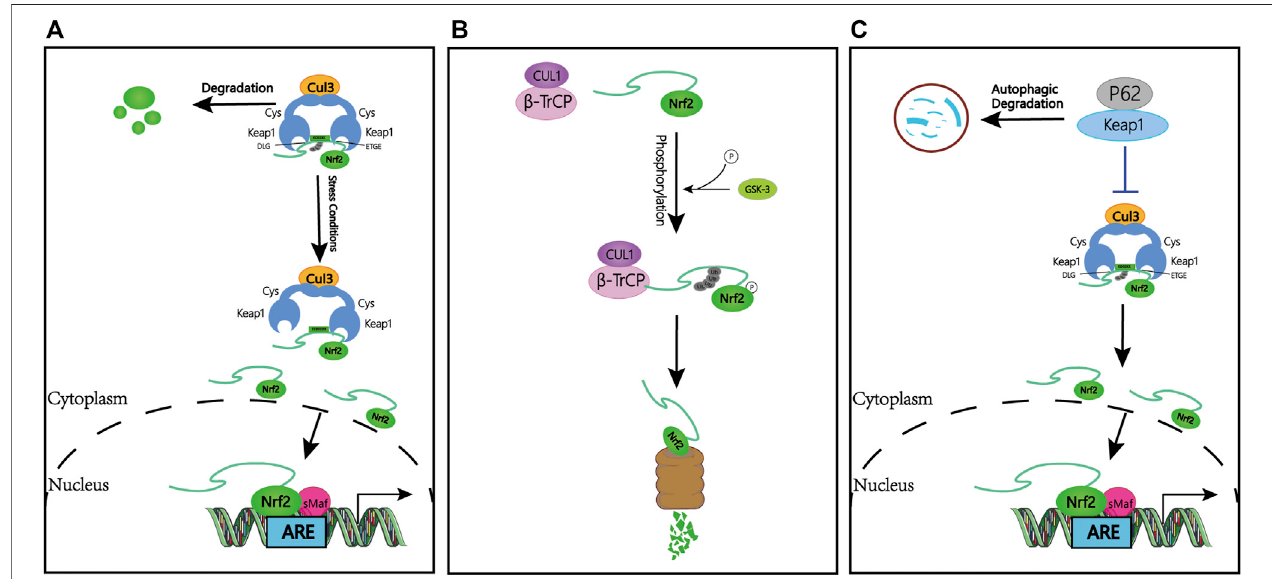
FIGURE 1 | Keap1-dependent and -independent regulation of Nrf2. (A) Keap1-dependent Nrf2 regulation. Under normal conditions, Nrf2 is sequestered in the cytoplasmbyKeap1.Underoxidativestress,Nrf2dissociatesfromKeap1,translocatestothenucleusandactivatestheARE-genebattery. (B) Keap1-independentNrf2 regulation.PhosphorylationofNrf2byGSKfacilitatestherecognitionofNrf2by β -TrCPforCUL1-mediatedubiquitinationand subsequent proteasome degradation. (C) P62-dependent Nrf2 regulation. p62 is sequestered with Keap1 and increased Nrf2 signaling. Abbreviations: Keap1, Kelch-like ECH-associated protein 1; Nrf2, Nuclear Factor Erythroid (NF-E2)-Related Factor 2; ARE, antioxidant response element; GSK-3, Glycogen synthase kinase 3; β -TrCP, β -transducin repeat-containing protein; Ub, ubiquitin.